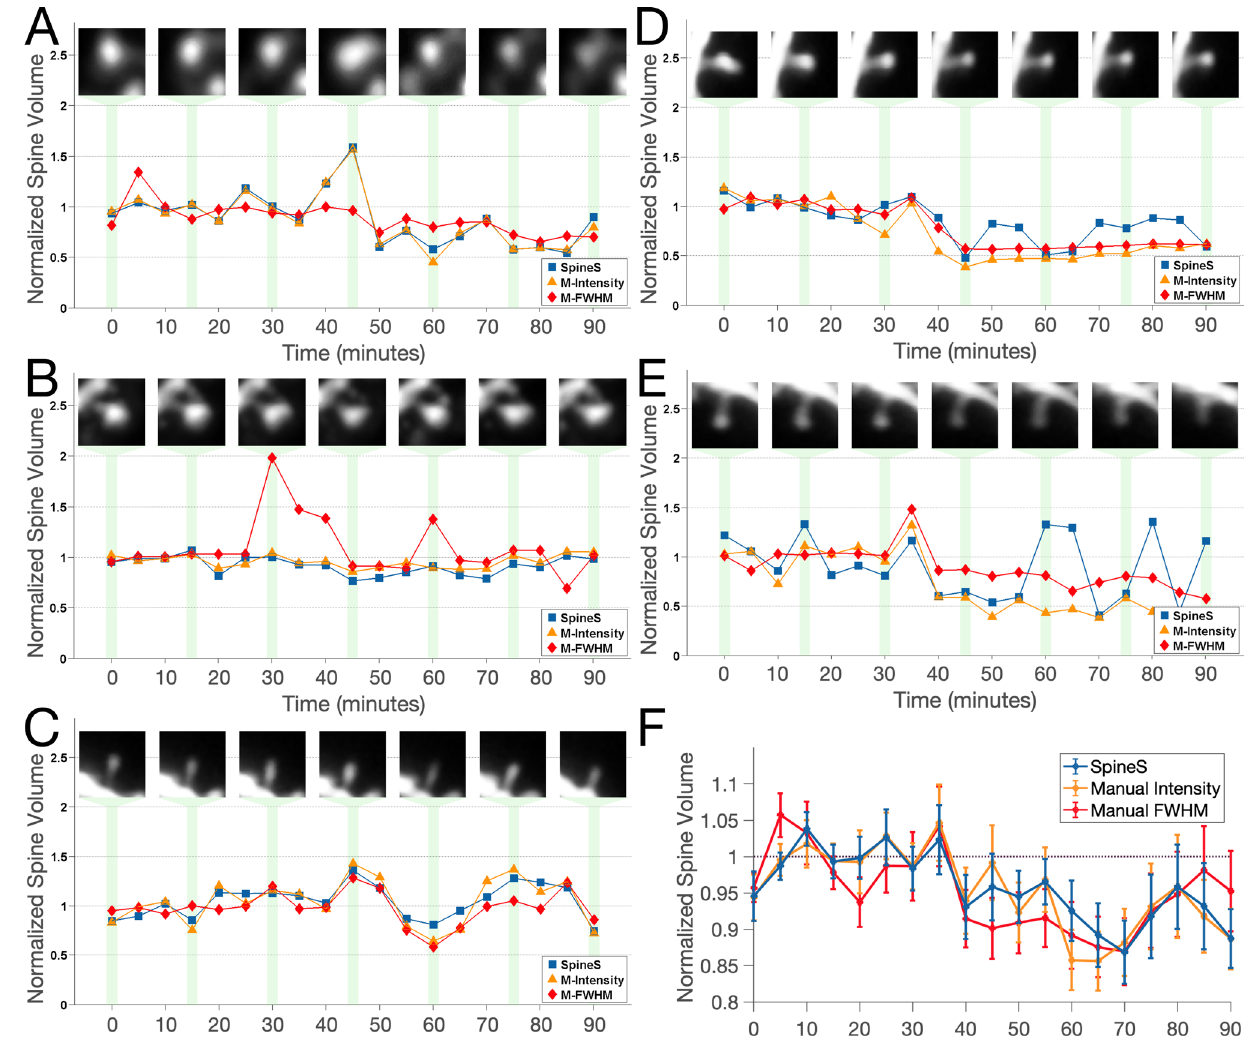
Figure 6. Comparison of automatic segmentation with manual segmentation and manual FWHM based volume estimation methods. ( A–E ) Five examples from a chemical LTD experiment. SpineS: IFI based volume using automatic segmentations; manual Intensity: IFI based volume using manual segmentations by an expert; manual FWHM: FWHM based volume quantified by a different expert. The chemical agent DHPG is applied before the 30 min time point. Volumes are normalised to the average baseline volume. Similarity scores between the different analysis methods are as follows: ( A ) SS S − MI = 97.09 , SS S − MF = 83.85 , SS MI − MF = 84.23 , ( B